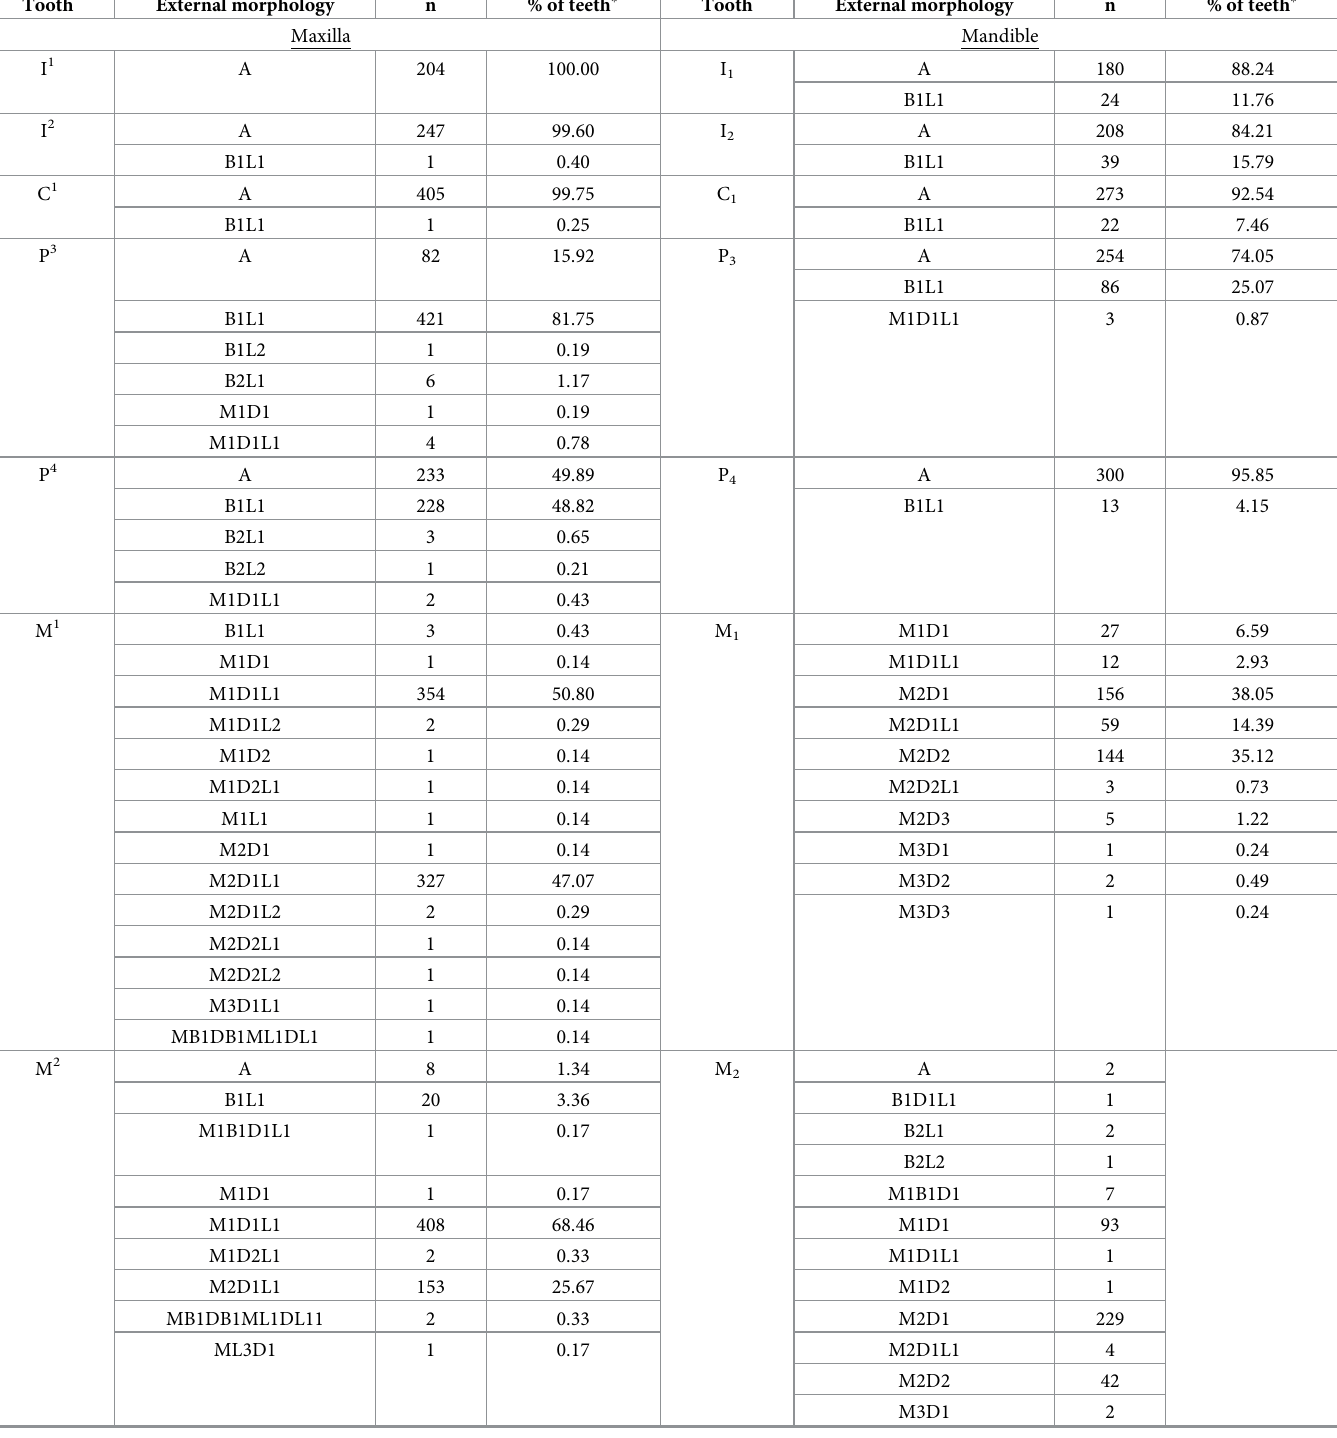
Table 5. Anatomical orientation of the canals in the maxilla and mandible by tooth.